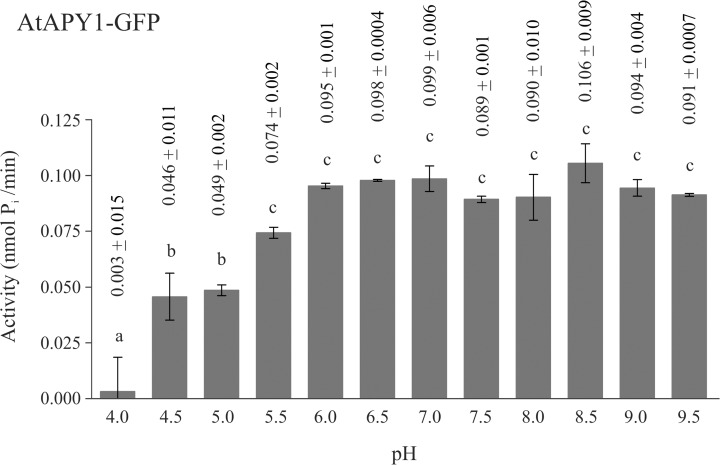
Influence of pH on AtAPY1-GFP activity.Enzyme activities were determined in the presence of 3 mM UDP using the discontinuous apyrase activity assay. The activity of AtAPY1-GFP was measured discontinuously over the pH range indicated. Different letters above the columns indicate mean values that are significantly different from one other (one-way ANOVA and Tukey test; p < 0.01). Error bars represent standard deviations of duplicates from one assay. The data are representative of four activity assays with independent protein extracts.